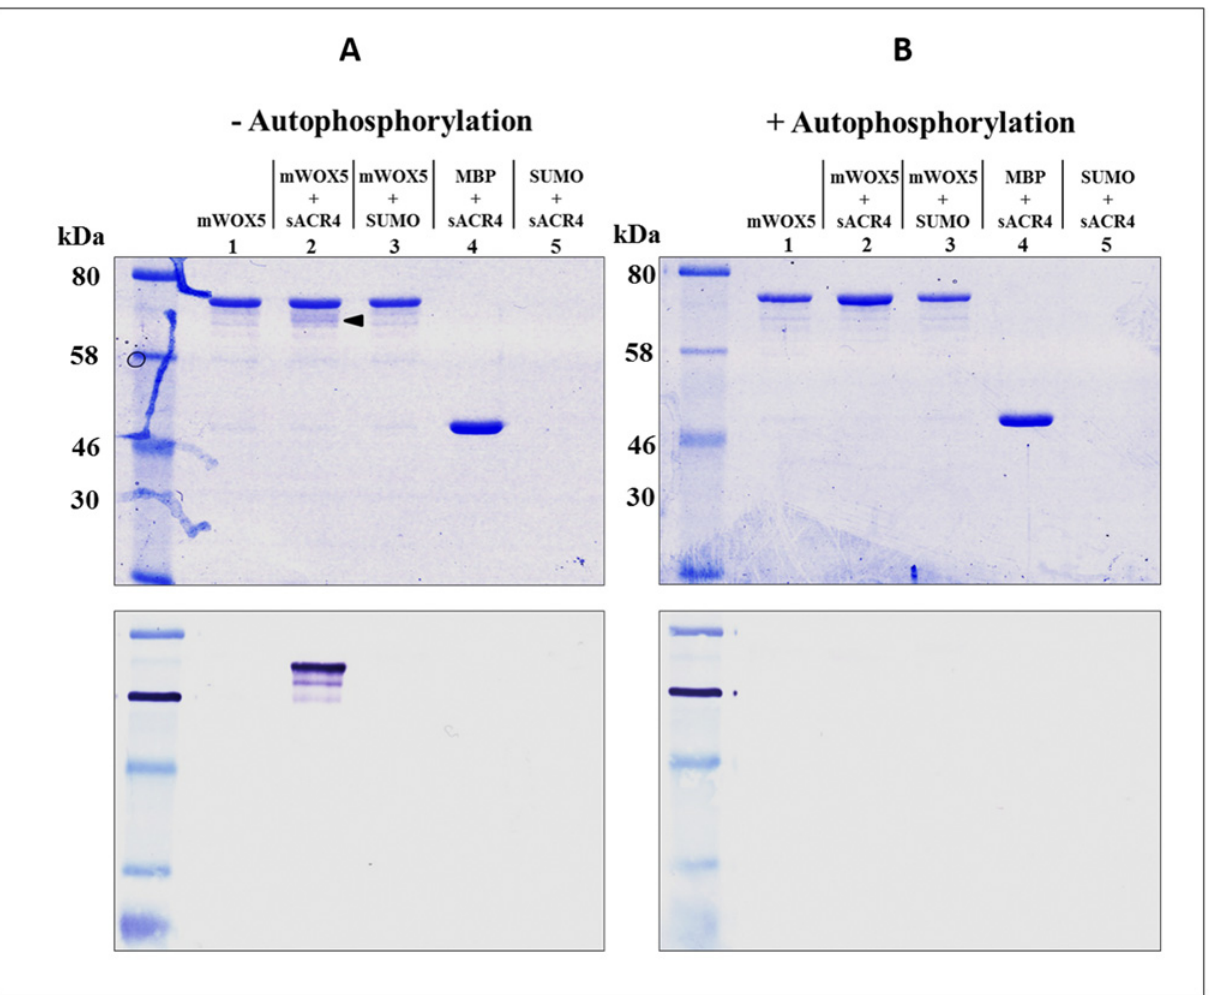
Fig 7. ACR4 ICD interaction with WOX5. The interaction between sACR4 and mWOX5 was determined by an in vitro pull-down assay. mWOX5 was incubated in the presence of unphosphorylated or phosphorylated sACR4 in parallel experiments. In (A), mWOX5 can specifically bind and pull-down na ï ve sACR4 ( lane 2 , arrow ). An anti-SUMO western blot confirmed sACR4 binding ( lower panel ). In controls, no binding is observed to SUMO alone ( lane 3 ) and MBP does not bind to sACR4 (lane 4) . In (B) mWOX5 cannot interact with autophosphorylated sACR4. In A and B, 12% SDS-PAGE separation of interacting proteins ( top panels ) and anti-SUMO western blots of proteins from each reaction ( lower panels